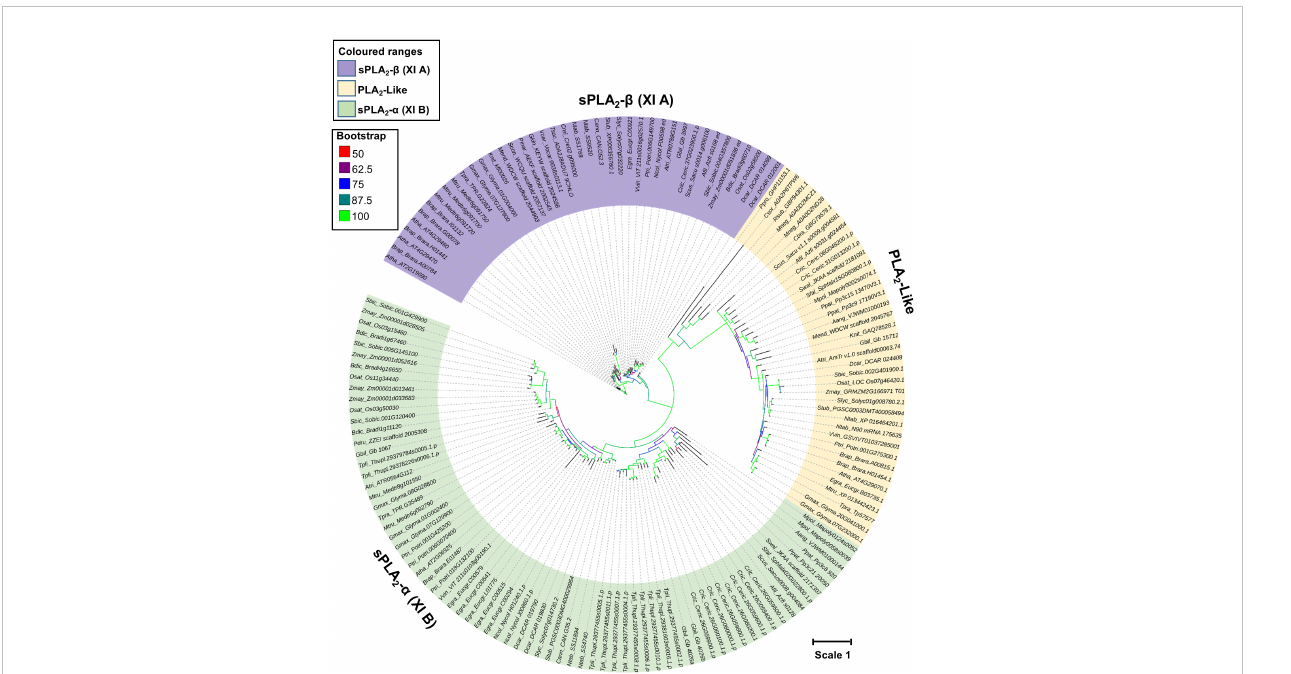
FIGURE 2 Phylogenetic relationships between sPLA 2 and PLA 2 -like members were constructed using the Maximum likelihood (ML) with the ultrafast bootstrap method. The evolution Whelan and Goldman model with Invariable and gamma (WAG+I+G4) was selected based on the Bayesian information criterion (BIC) score. Color nodes correspond to the bootstrap support. The scale bar indicates the rates of substitutions/site. Atha, Arabidopsis thaliana ; A fi l, Azolla fi liculoides ; Aang, Anthocerus angustus ; Atri, Amborella trichopoda ; Brap, Brassica rapa ; Bdic, Brachypodium distachyon ; Cann, Capsicum annuum ; Crei, Chlamydomonas reinhardtii ; Csor, Chlorella sorokiniana ; Cric, Ceratopteris_richardii ; Dcar, Daucus carota ; Egra, Eucalyptus grandis ; Gbil, Ginkgo biloba ; Gmax, Glycine max ; Gkin, Gonatozygon_kinahanii ; Knit, Klebsormidium nitens ; Mneg, Monoraphidium neglectum; Mpol, Marchantia polymorpha ; Mtru, Medicago truncatula ; Mend, Mesotaenium endlicherianum ; Ntab, Nicotiana tabacum ; Ncol, Nymphaea colorata ; Osat, Oryza sativa ; Pdru, Phylloglossum drummondii ; Ptri, Populus trichocarpa ; Pmar, Penium margaritaceum ; Ppat, Physcomitrium patens ; Ppro; Pycnococcus provasolii ; Slyc, Solanum lycopersicum ; Stub, Solanum tuberosum ; Sbic, Sorghum bicolor ; Tpli, Thuja plicata ; Rsub, Raphidocelis subcapitata ; Scon, Staurodesmus_convergens ; Swal, Selaginella_wallacei ; Sfal, Sphagnumfallax ; Scus, Salvinia cucullata ; Tsoc, Tetrabaena